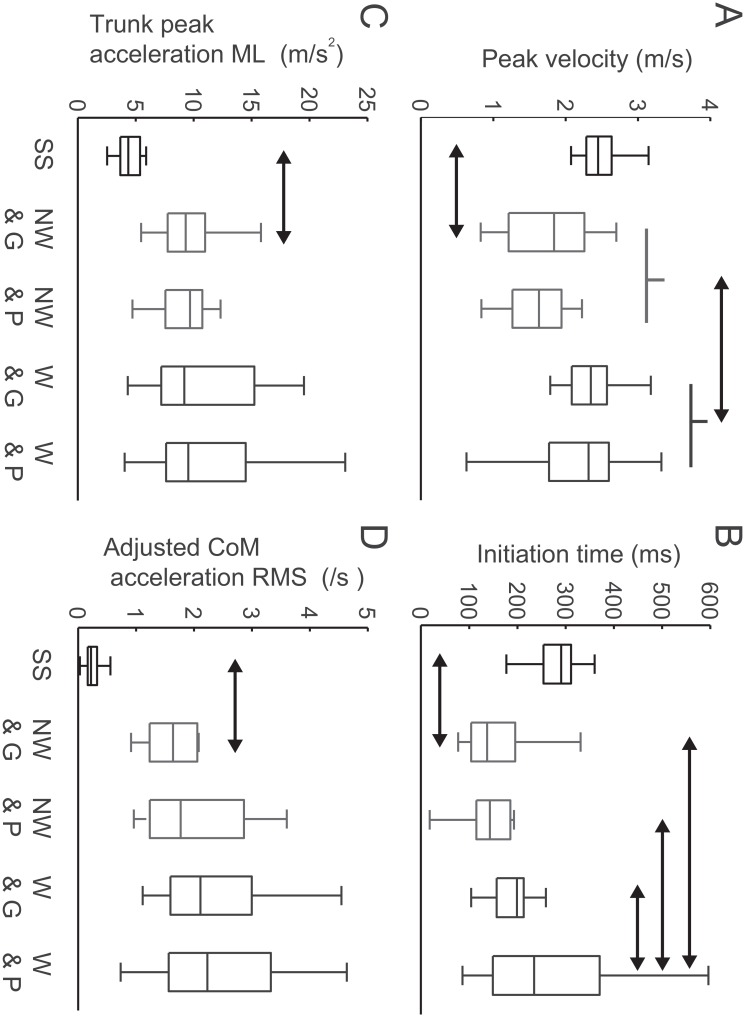
Movement kinematic parameters.Boxplots including median value and the 25th and 75th percentiles in (A) mediolateral trunk peak velocity, (B) initiation time, (C) mediolateral trunk peak acceleration and (D) root mean squares of center of mass acceleration in choice-reaction sidestep normalized by peak mediolateral trunk velocity (SS, black), non-weighted in guarding (NW & G, light gray) and penetrating trials (NW & P, light gray), and weighted in guarding (W & G, dark gray) and penetrating trials (W & P, dark gray). Horizontal arrows represent statistically significant differences between SS and NW & G or between NW and W.